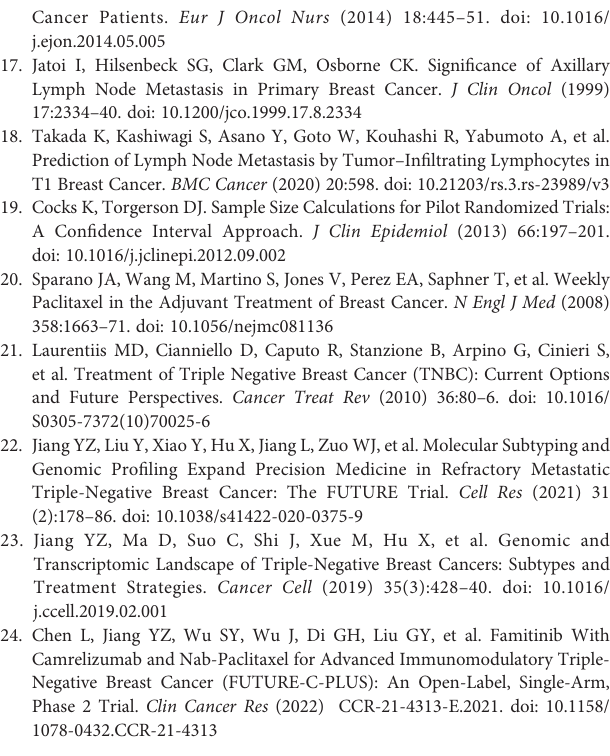
Supplementary Table 1 | Recruitment of patients by hospital and cancer center. Supplementary Table 2 | Summary of main chemotherapy regimens. EC-P, epirubicin and cyclophosphamide plus paclitaxel (Taxol); EC, epirubicin